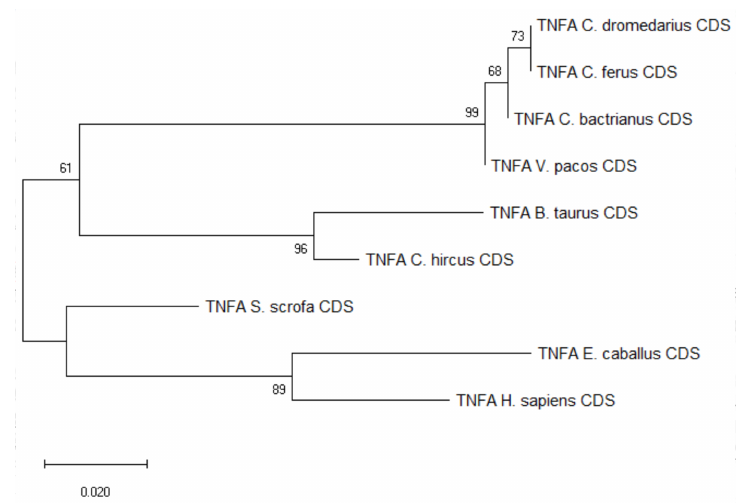
Figure 2. Phylogenetic tree of the TNFA CDSs from selected species. The maximum-likelihood method was used based on the Tamura 3-parameter model with gamma distribution (five categories, parameter = 0.1968). The number of bootstraps was